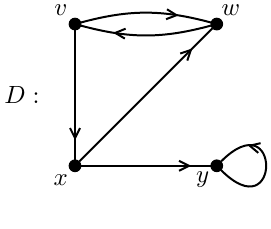
Figure 7: A connection